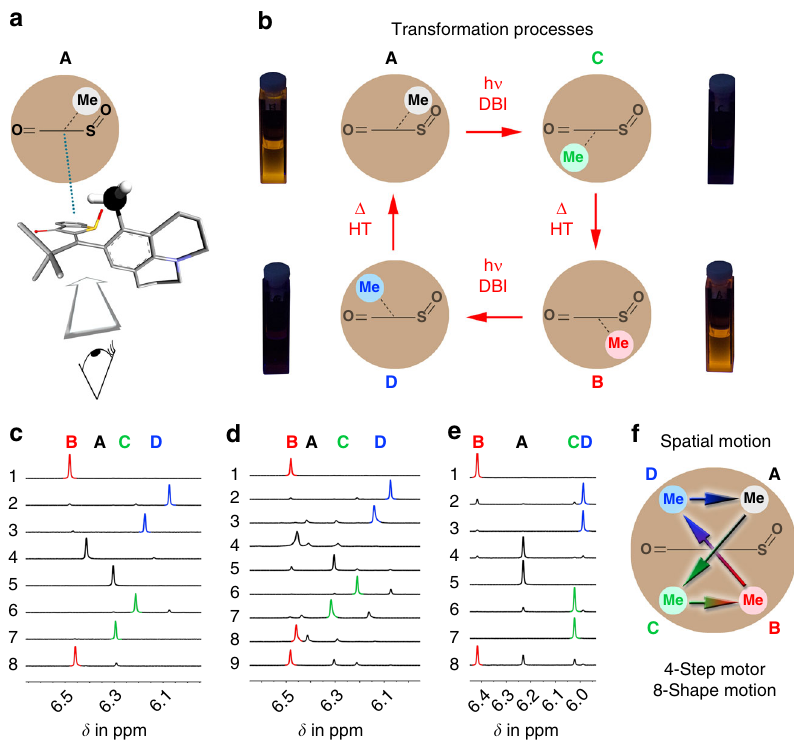
Fig. 3 Molecular motor properties of 1 . a Schematic representation of the geometry of A . b Four-step process of the motor motion and associated fl uorescence changes. c Individual steps of motor operation followed by 1 H NMR spectroscopy, (1) B in cyclohexane- d 12 , (2) after 520 nm irradiation, (3) D in acetonitrile- d 3 /D 2 O (8/2), (4) after heating to 27 °C, (5) A in cyclohexane- d 12 , (6) after 520 nm irradiation, (7) C in acetonitrile- d 3 /D 2 O (8/2), (8) after heating to 60 °C. d One full cycle of motor operation followed by 1 H NMR spectroscopy, (1) B in cyclohexane- d 12 , (2) after 520 nm irradiation, (3) after solvent change to acetonitrile- d 3 /D 2 O (8/2), (4) after heating to 60 °C, (5) after solvent change to cyclohexane- d 12 , (6) after irradiation with 520 nm, (7) after solvent change to acetonitrile- d 3 /D 2 O (8/2), (8) after heating to 60 °C, (9) after solvent change to cyclohexane- d 12 . e Individual steps of autonomous motor operation followed by 1 H NMR spectroscopy in 12DCB- d 4 , (1) pure B , (2) after 520nm irradiation, (3) pure D , (4) after heating to 130 °C, (5) pure A , (6) after 520 nm irradiation, (7) pure C , (8) after heating to 130 °C. f Positional changes of the methyl group with respect to the